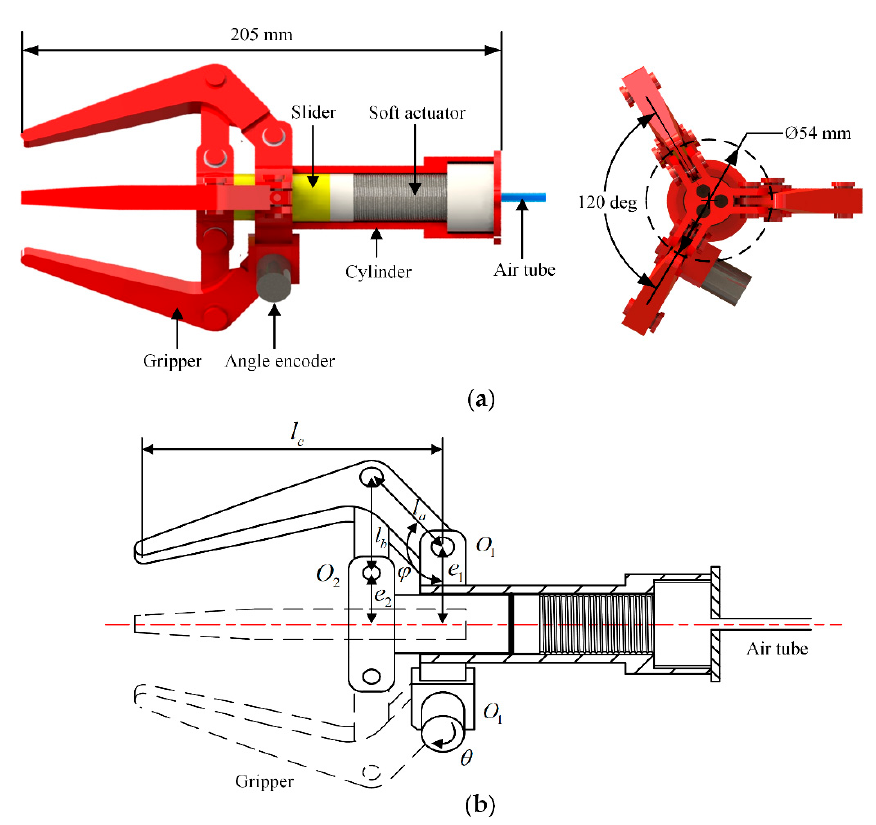
Figure 1. Design diagram of the soft-rigid gripper: ( a ) gripper actuated by a linear-extension soft pneumatic actuator; ( b ) schematic of the gripper.